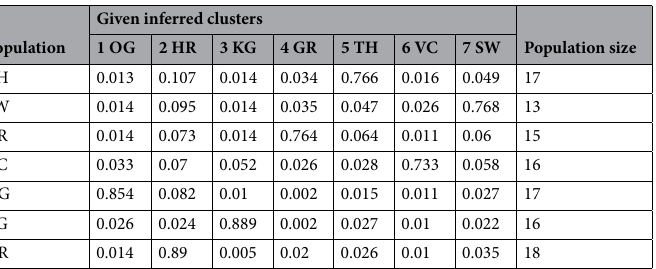
Table 5. Proportion of membership of each pre-defined population in each of 7 clusters. SW-Sahiwal, TP-Tharparkar, GR-Gir, VC-Vechur, OG-Ongole, KG-Kangayam, HR-Hariana.